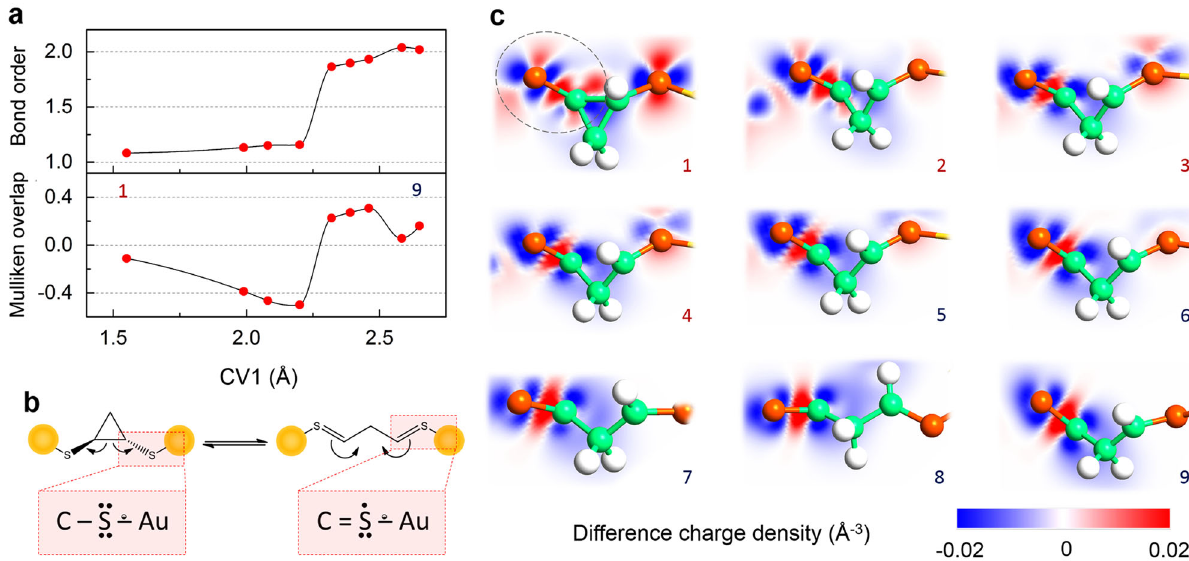
Fig. 4 C – S bond order transition and electron distribution in ring-opening reaction. a The change of bond order and Mulliken overlap of C1 – S1 as CV1 (the distance of C1 – C3) increases from 1.6 to 2.6 Å. b Electron redistribution near S atom in ring-opening/-closure reaction. The solid dot is the local electron from S; the semi-hollow dot is the delocalized partial electrons from Au; the line is the bond between atoms. c The change of difference charge density in the C1 – S1 bond region for 9